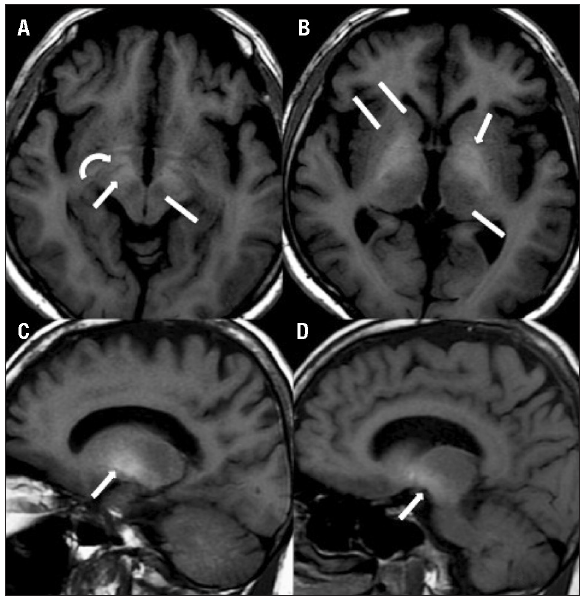
Figure 1. [A,B] Axial T1-weighted magnetic resonance imaging shows sym- metrical bilateral hyperintensities involving the substantia nigra (arrow in A), the anterior midbrain (curved arrow in A) and the globus pallidus (arrow in B). The putamen, caudate, thalamus (lines in B) and red nucleus (line in A) are spared. [C,D] Sagittal T1-weighted magnetic resonance imaging also demonstrates hyperintensities in the globus pallidus (arrow in C) and substantia nigra (arrow in D).